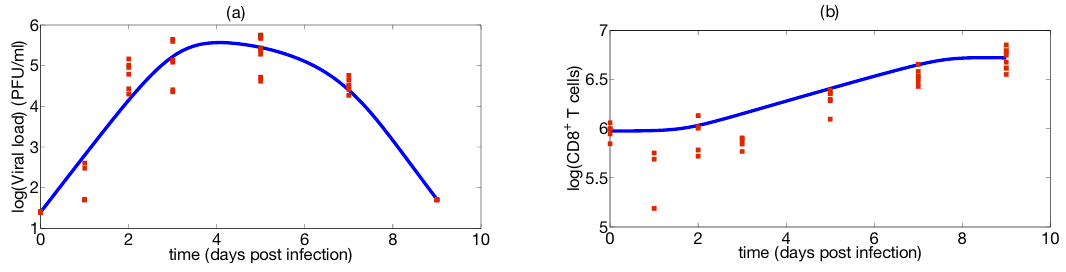
Figure 6. Viral infection model fitting: ( a ) The model fitting is shown with a blue line, viral load data is presented in red squares for mice infected with the IAV (H1N1) (PR8) strain; ( b ) the model fitting is shown in a blue line, the CTLs data is presented in red squares.